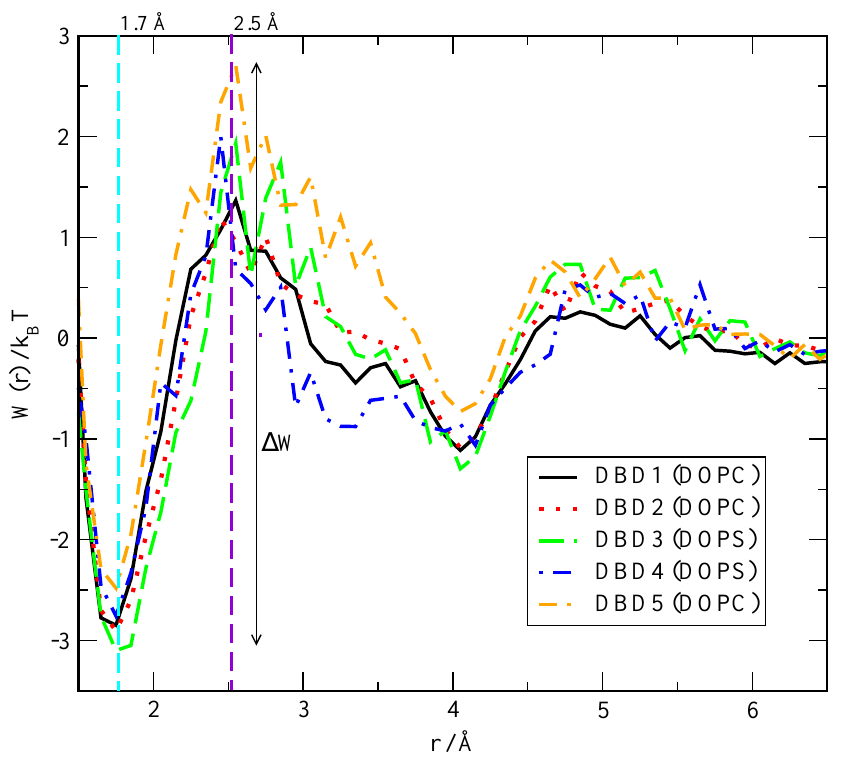
Figure 6. Potentials of mean force for the binding of ‘H2’ sites of DBD derivatives to the sites ‘O13-14’ of DOPC and